Question: Based on the figure, does the quantity rise or fall?
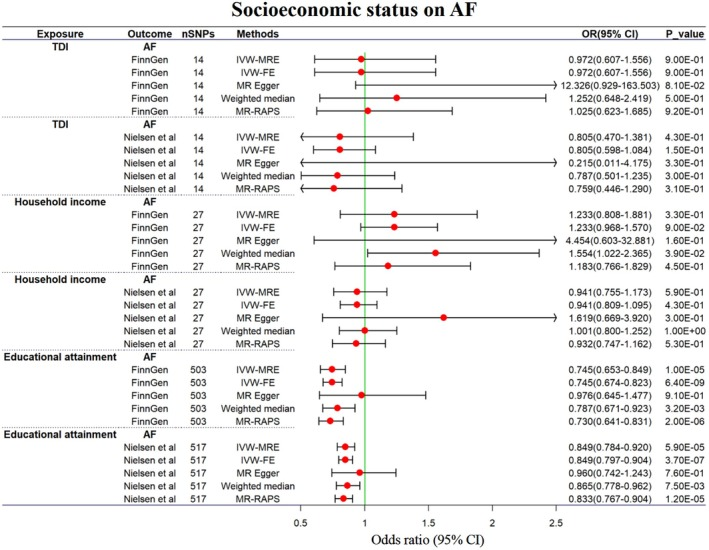
Answer: increasing